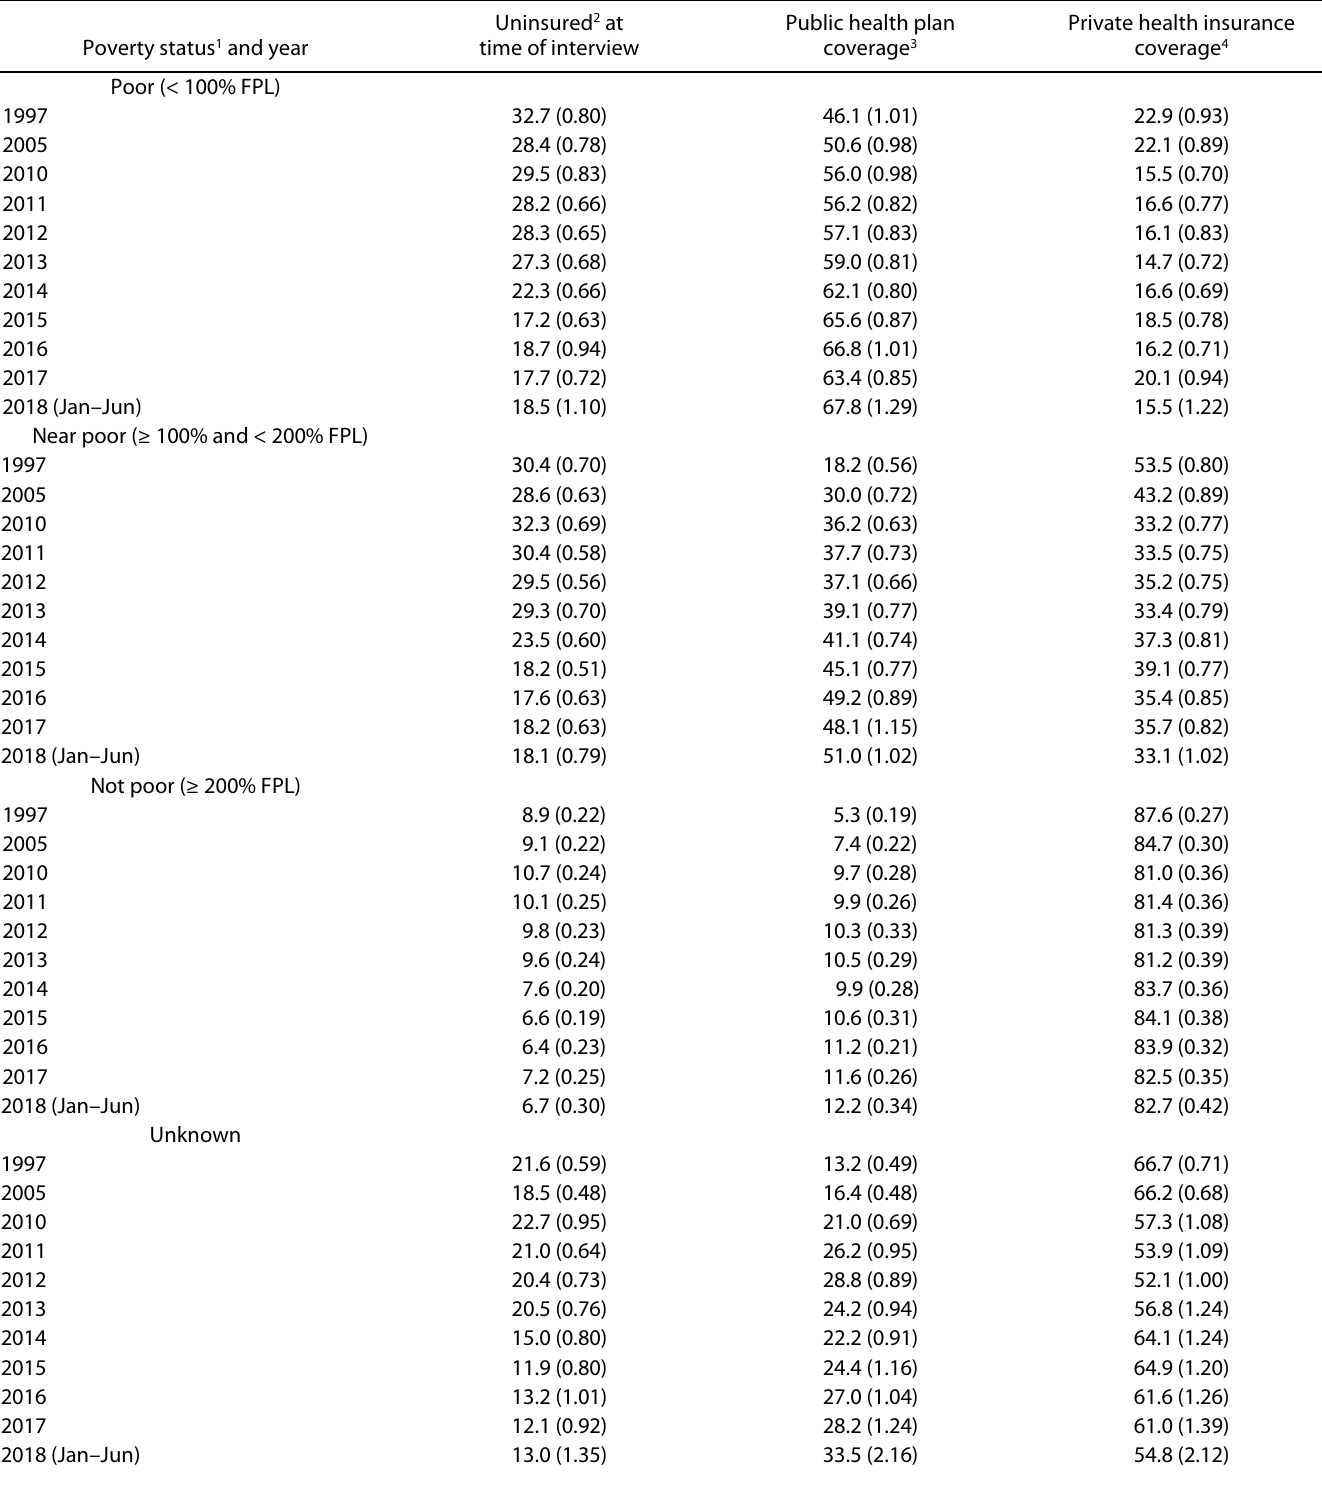
Table IV. Percentages (and standard errors) of persons under age 65 who lacked health insurance coverage, had public health plan coverage, and had private health insurance coverage at the time of interview, by poverty status and selected years: United